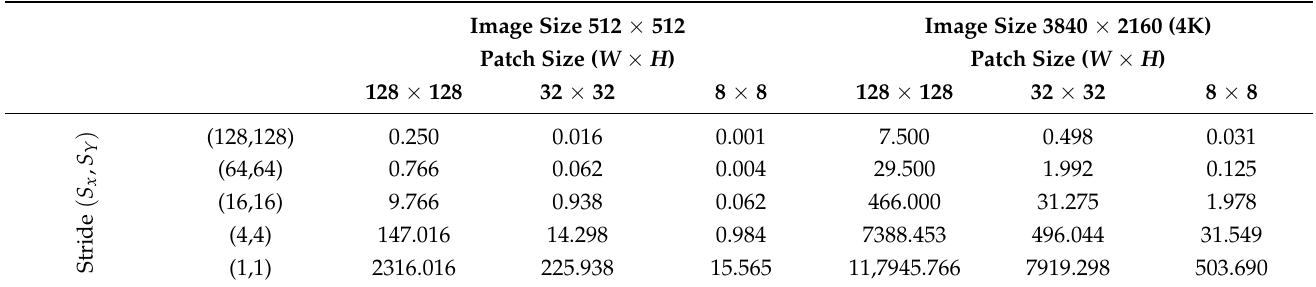
Table 2. Memory requirements (in megabytes, MB) assuming 1 byte/pixel for various stride and patch sizes when applied to two monochromatic images ( B = 1) with dimensions of 512 × 512 and 3840 × 2160 pixels,